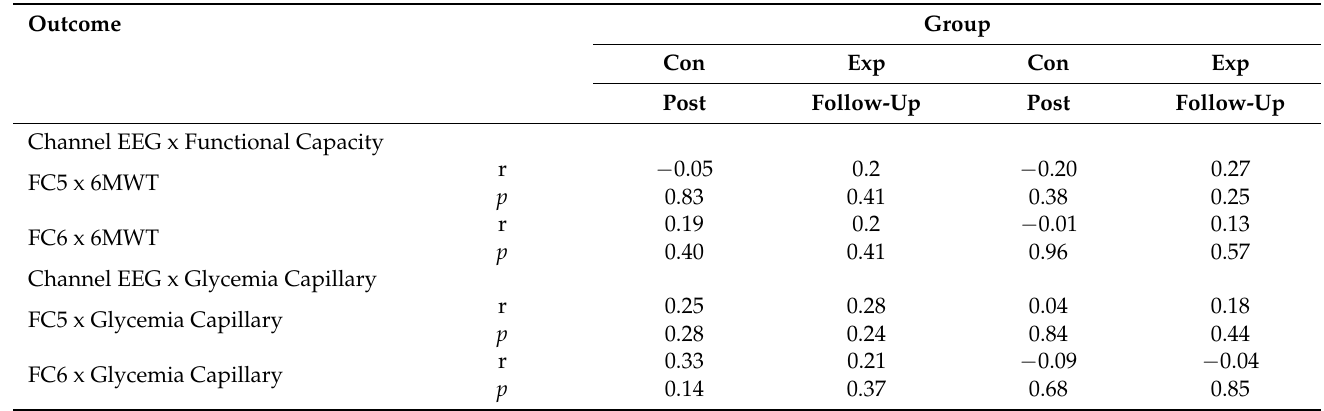
Table 4. Correlation of FC5 and FC6 channels with capillary glycemia and functional